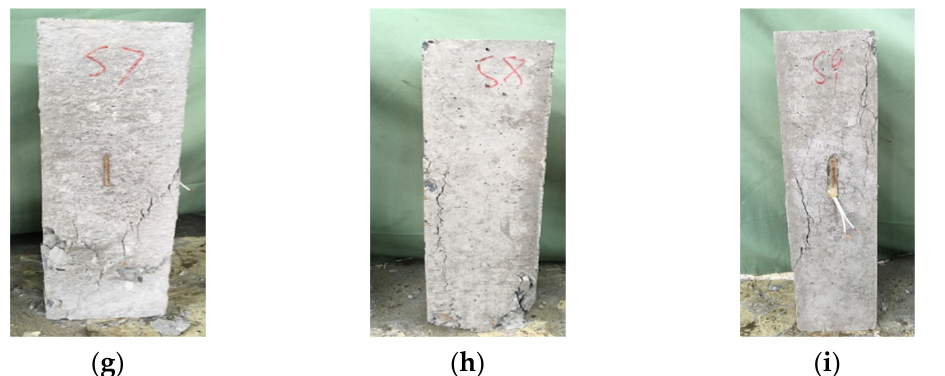
Figure 6. The failure mode of the short columns: ( a ) S1; ( b ) S2; ( c ) S3; ( d ) S4; ( e ) S5; ( f ) S6; ( g ) S7; ( h ) S8; and ( i ) S9.